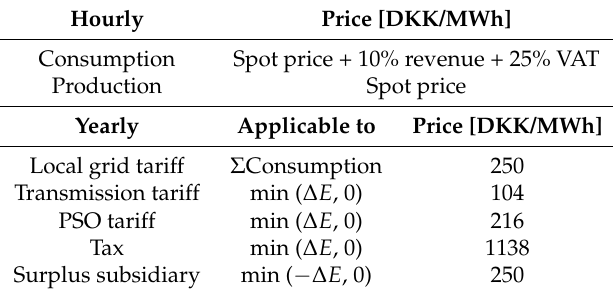
Table 2. Flexible pricing scheme for residential PV systems in Denmark